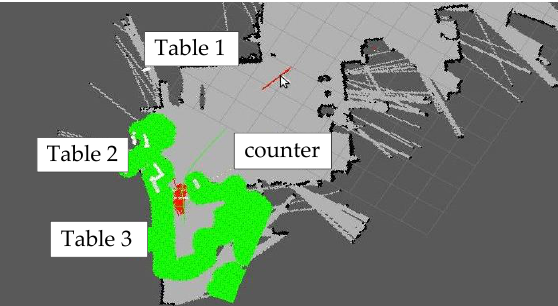
Figure 7. The experimental setup in a grid map.